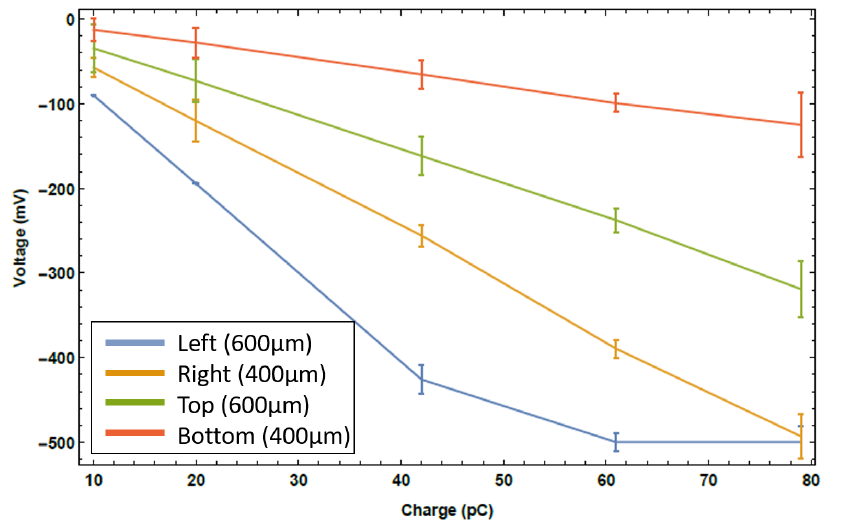
Figure 8. The Cherenkov signal intensity as a result of beam loss as a function of bunch charge for the four optical